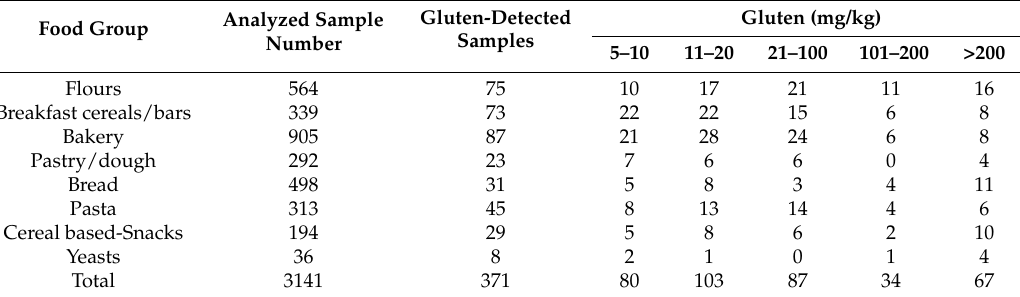
Table A1. Summary of results obtained in gluten detection analysis from 1998 to